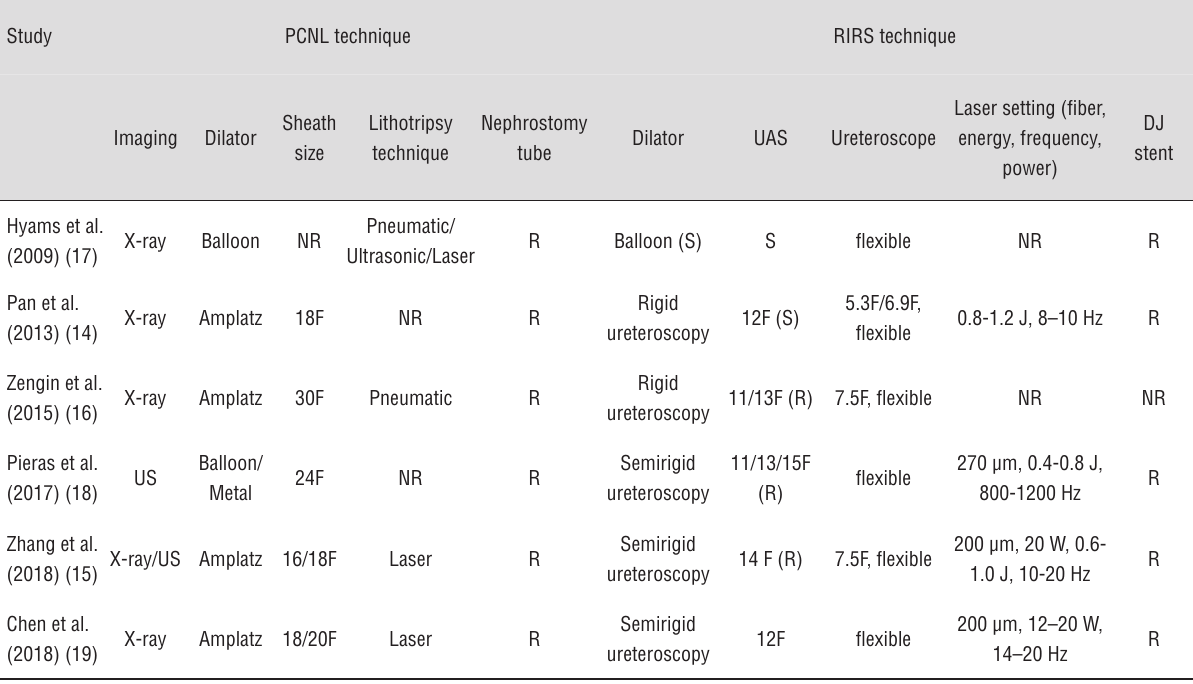
Table 2 - An overview of techniques applied in PcNL and